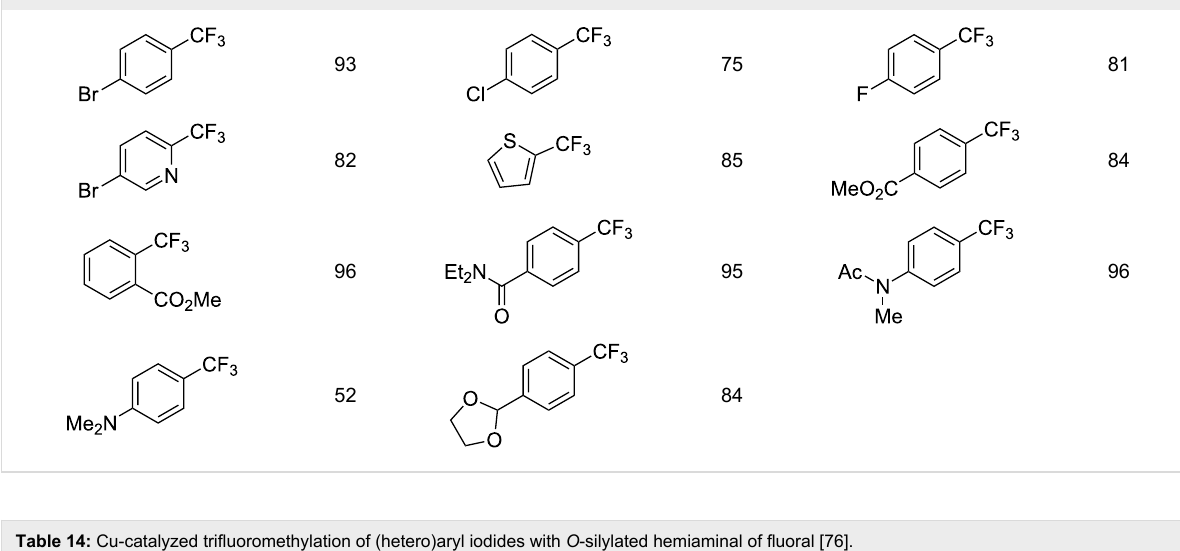
Table 13: Cu-catalyzed trifluoromethylation of (hetero)aryl iodides with (trifluoromethyl)trimethoxyborate [74]. (continued)